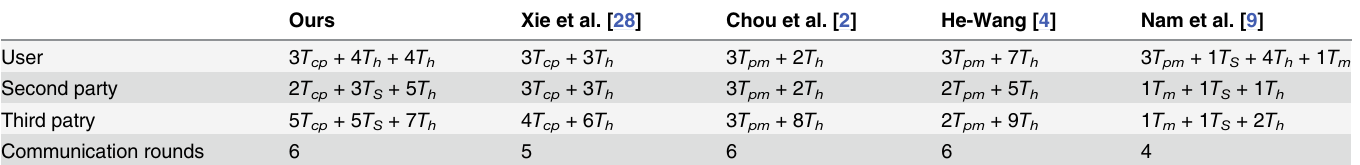
Table 3. Performance comparison.